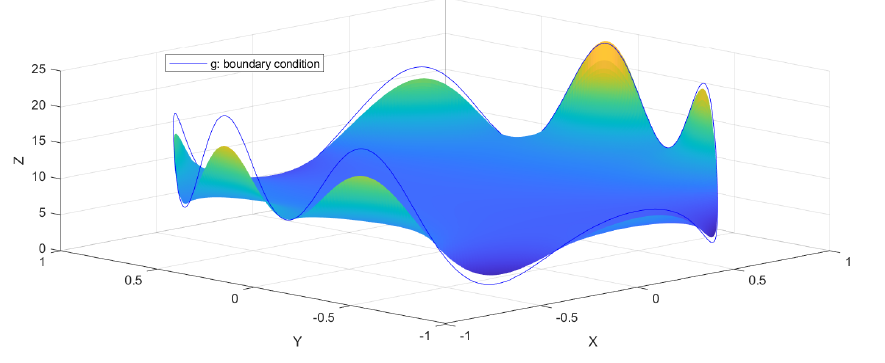
Figure 2. Pointwise error of the numerical solution ˜ u h of (21) for α = 0.75 and N = 512 inside the boundary. One can observe that the most of the error accumulates close to the boundary.